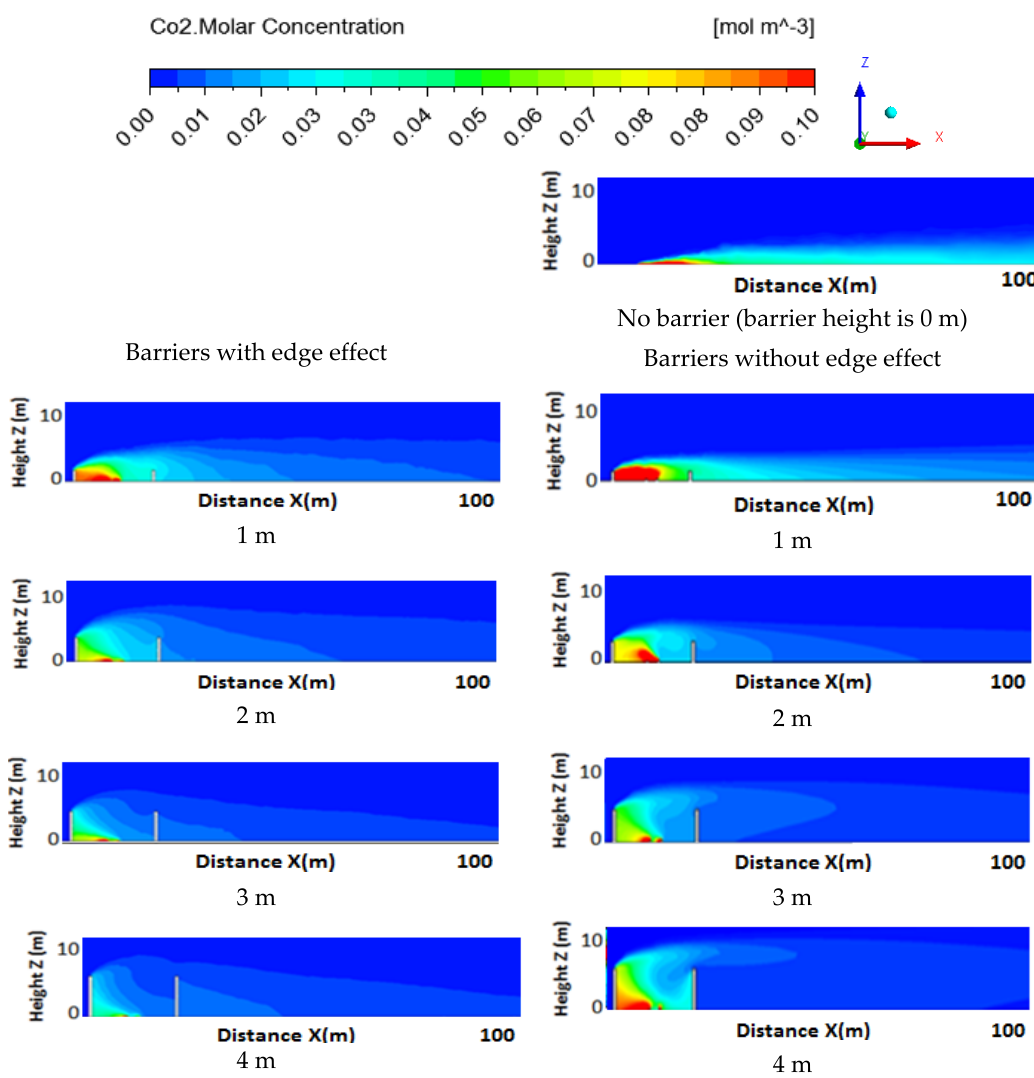
Figure 11. CO 2 concentration at different downwind distances within 10 m height.